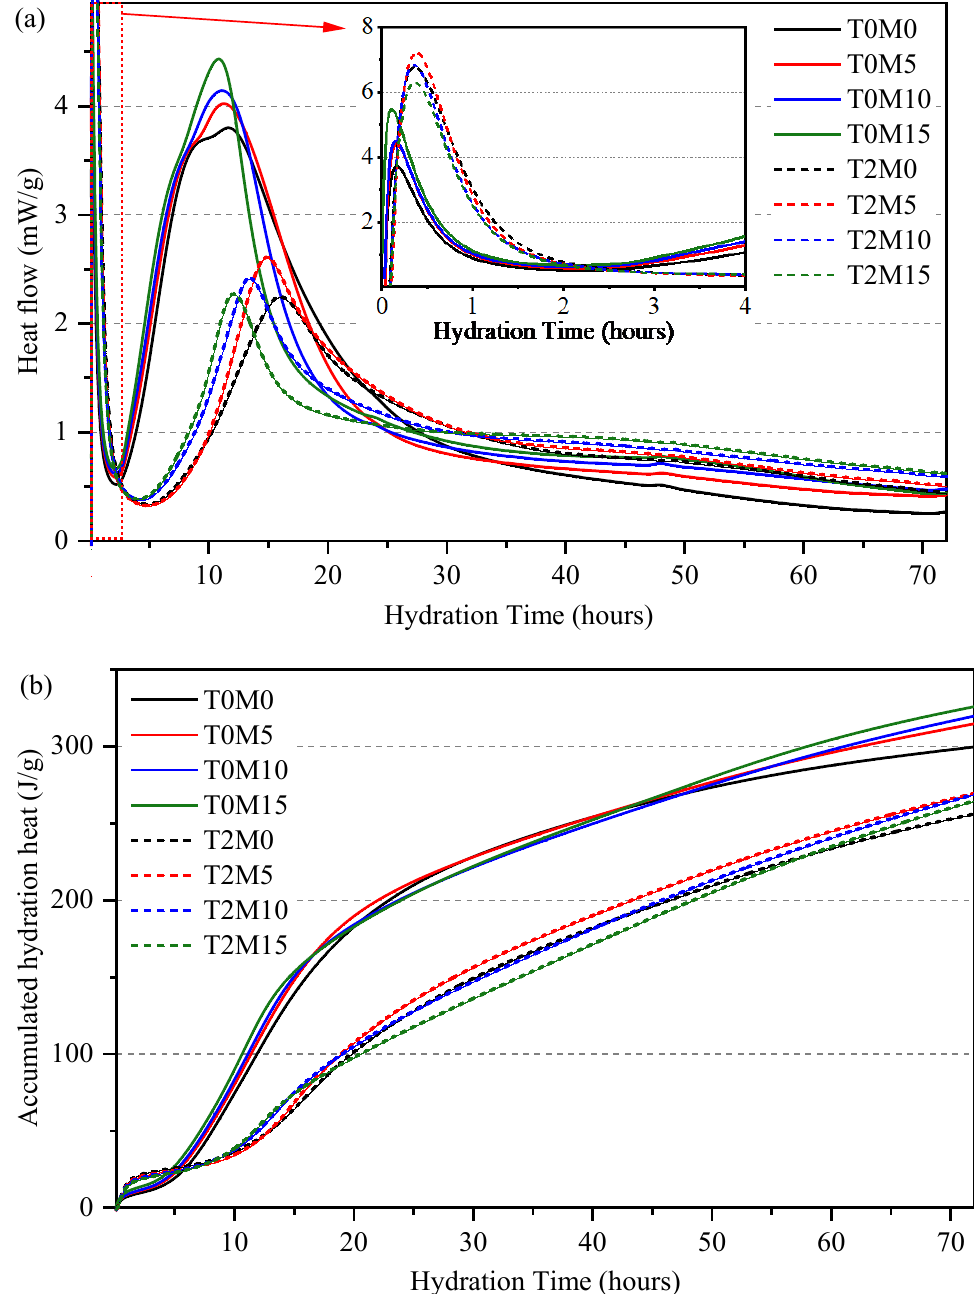
Figure 3. Hydration kinetics of the metakaolin blended cement pastes with black tea extracts: ( a ) thermal power; ( b ) accumulated heat.